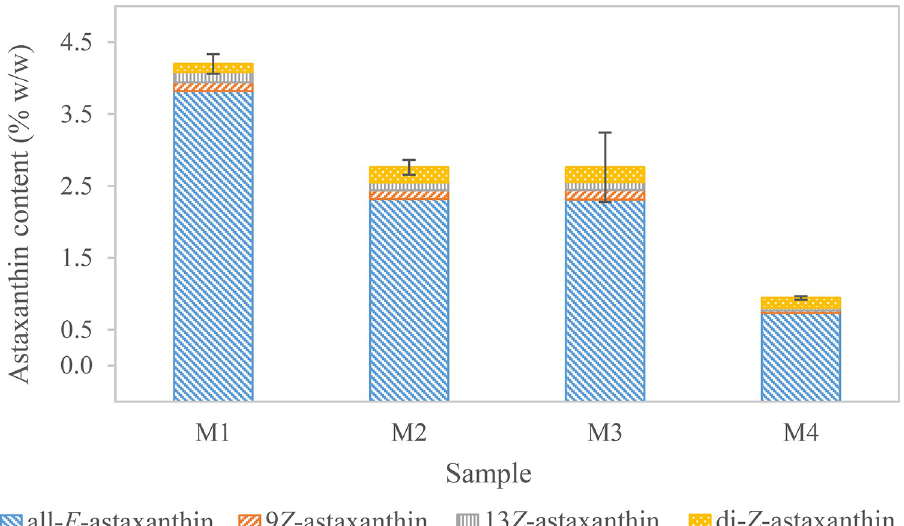
Fig 7. Astaxanthin content of four batches of H . pluvialis suspended in residual medium. M1 to M4 derive from different batches. Standard deviations are indicated for total astaxanthin. Replicates of M1 to M4 vary between three and five. Standard deviations for the individual isomers and replicates can be found in S1